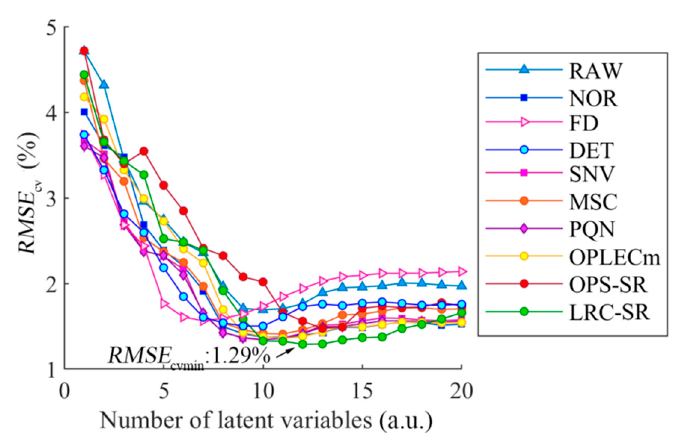
Figure 7. Root mean square errors of partial least squares regression models for the cross-validation of juiciness with 1–20 latent variables. RMSE cv represents the root mean square error of cross-validation, RMSE cvmin represents the minimum value of RMSE cv , a.u. stands for arbitrary